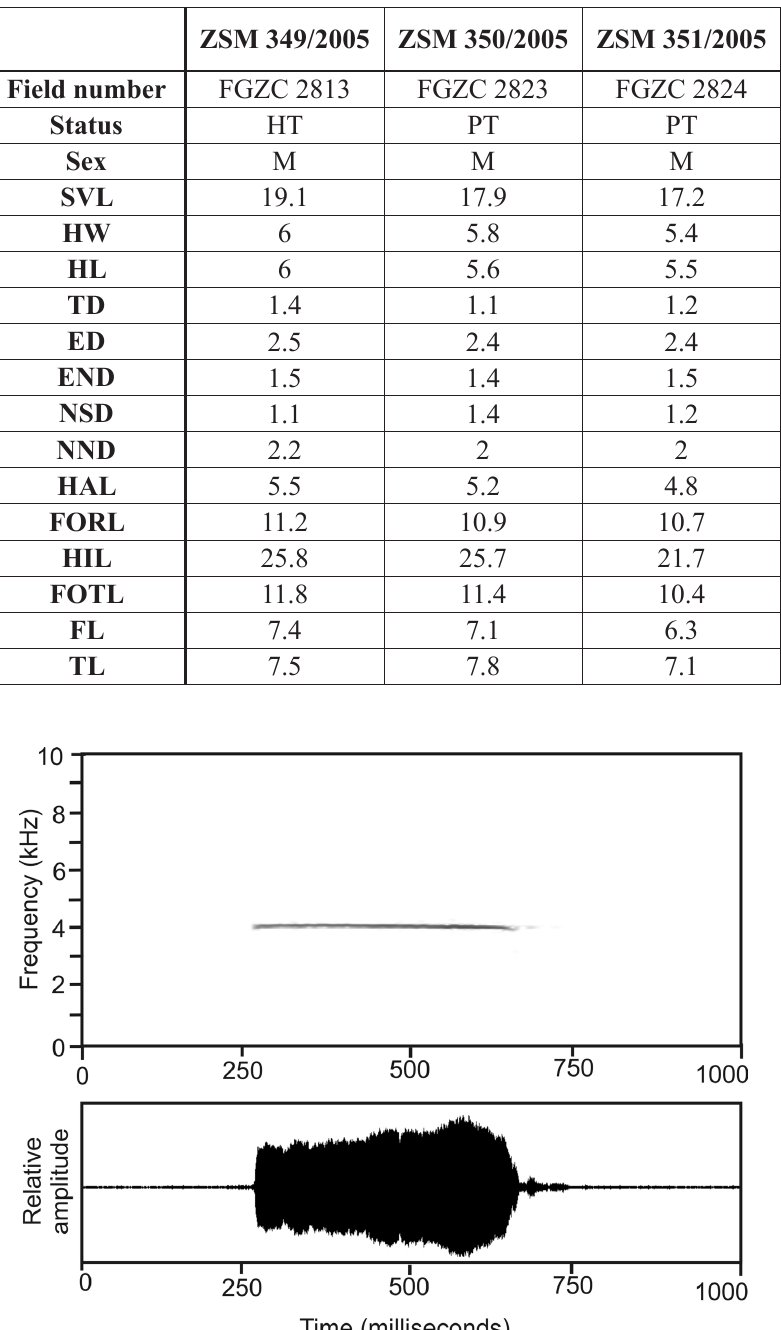
Table 1. Morphometric measurements (all in mm) of holotype (HT) and two paratypes (PT) of Platypelis ravus. For abbreviations of measured variables, see Materials and methods; further abbreviations used: M (male); F (female). Tympanum diameter (TD) values in brackets indicate that the tympanum was not distinct. In all specimens, third and fifth toe were of equal length, and the tibiotarsal articulation reaches tympanum when hindlimbs are adpressed along body.